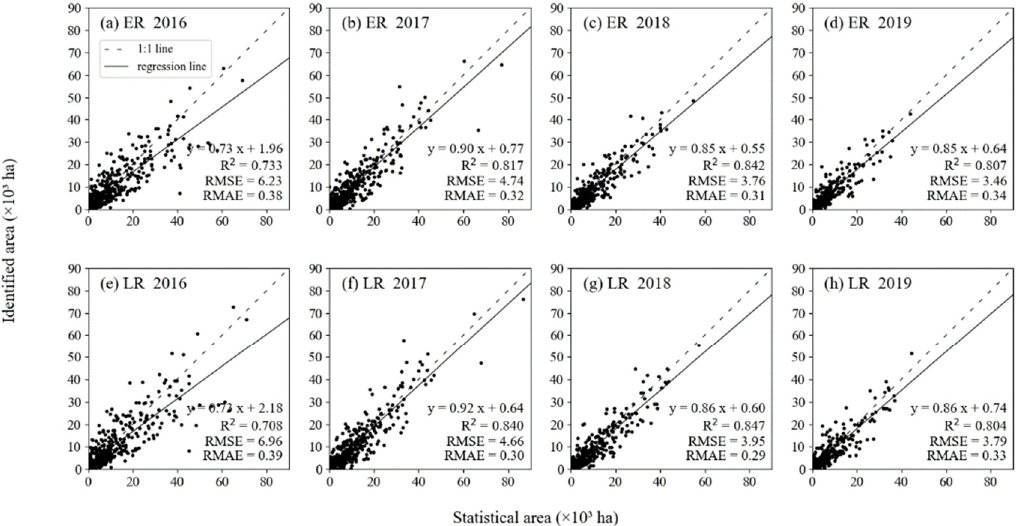
Figure 6. County-level comparison of identified and statistical planting areas from 2016–2019, for early rice ( a – d ) and late rice ( e – h ).